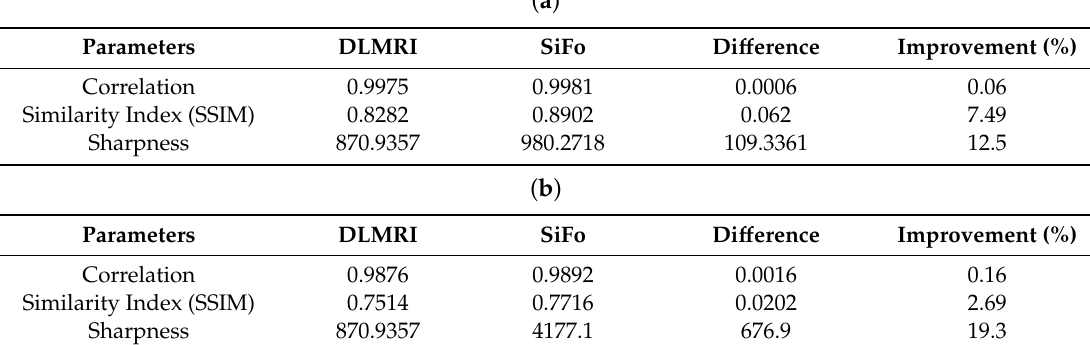
Table 2. Performance parameters comparison of SiFo vs. DLMRI algorithms in a noisy case for (a)